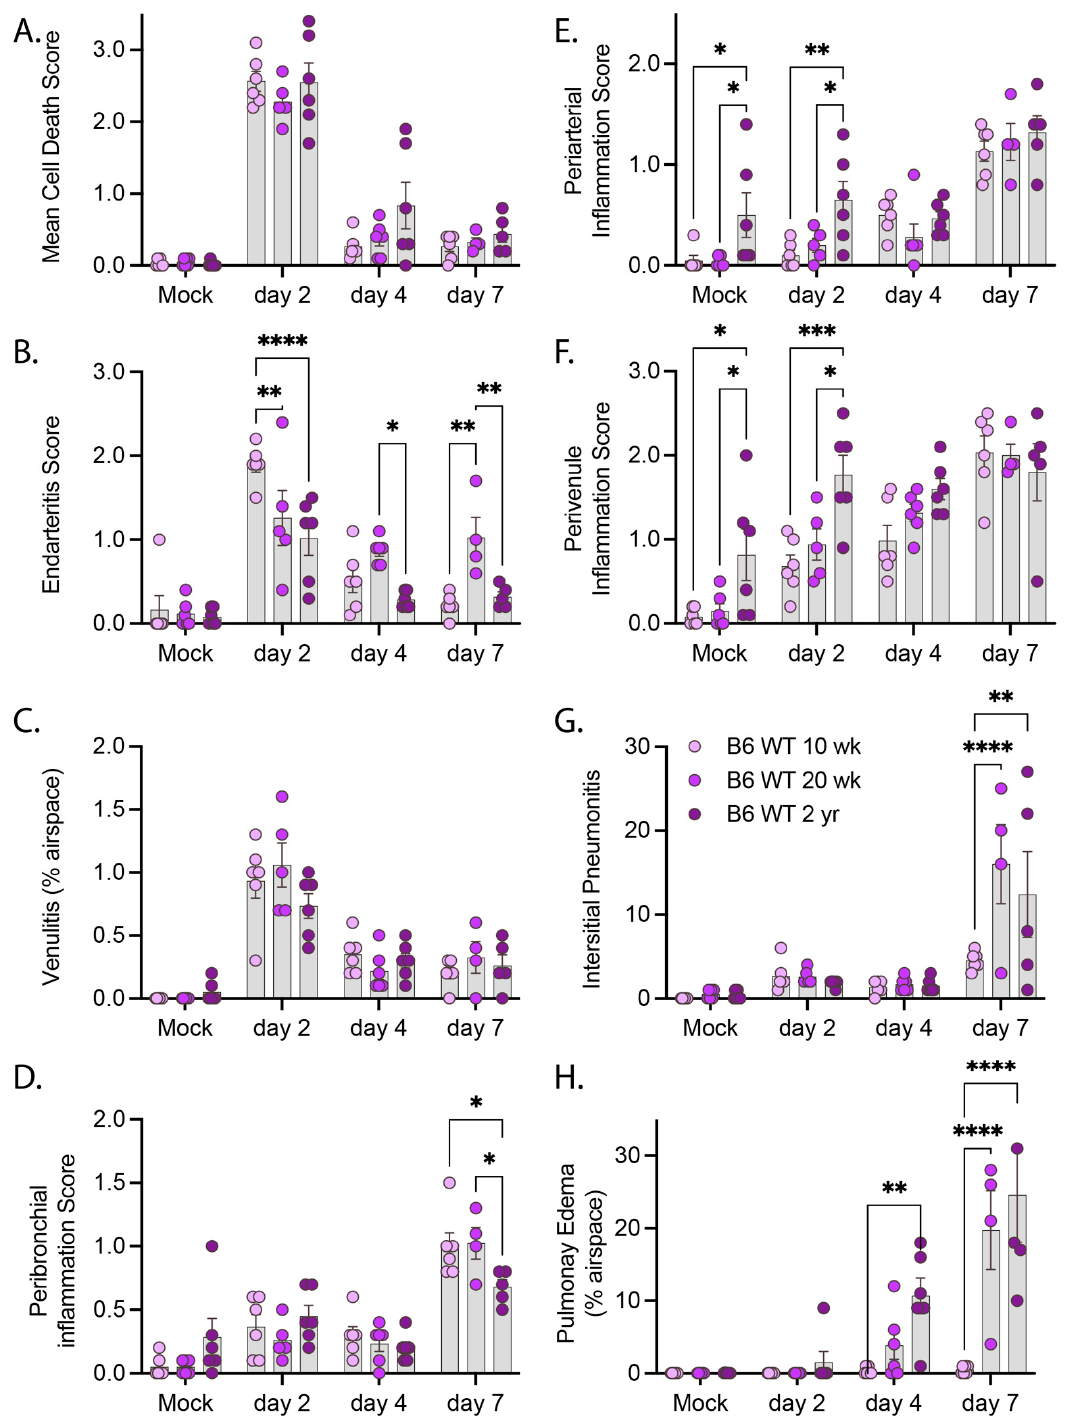
Figure 6. Pathology summary of lung tissue from of 10 wk-old, 20 wk-old, and 2 yr-old mice infected with R2G. Tissue was collected either 2, 4, or 7 days post infection or 7 days post mock infection from the 10 wk-, 20 wk-, and 2 yr-old male and female mice discussed in Figure 4. Data represent pathology scores from H&E stained FFPE tissue sections, and representative images can be found in Supplementary Figure S4. ( A ) Mean Cell Death, ( B ) Endarteritis, ( C ) Venulitis, ( D ) Peribronchial inflammatory, ( E ) Periarterial inflammation, ( F ) Perivenule inflammation, ( G ) Interstitial Pneumonitis, and ( H ) Pulmonary Edema. Significance tested by 2-way ANOVA with Tukey’s adjustment for multiple comparisons, where * is p ≤ 0.05, ** is p ≤ 0.01, *** is p ≤ 0.001, and **** is p ≤